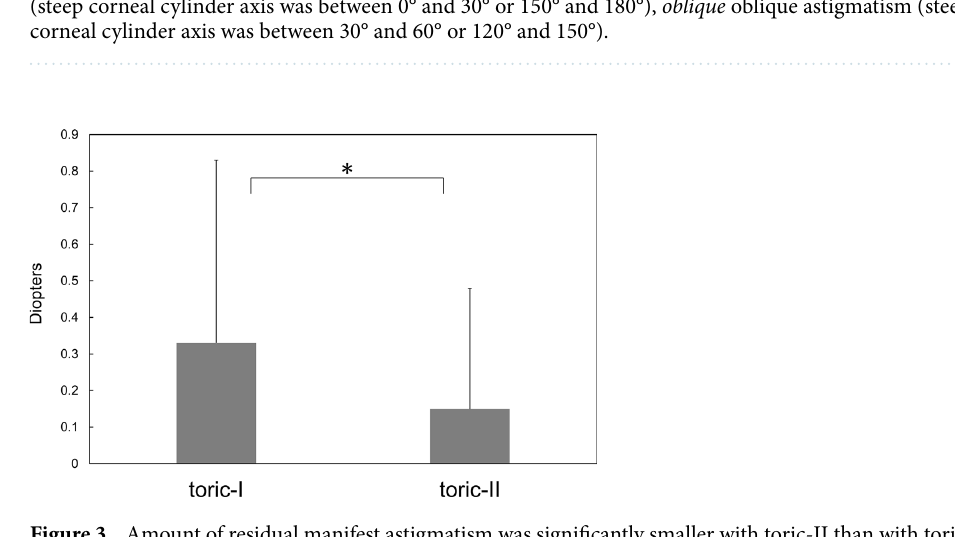
Figure 3. Amount of residual manifest astigmatism was significantly smaller with toric-II than with toric-I IOLs (p = 0.018).